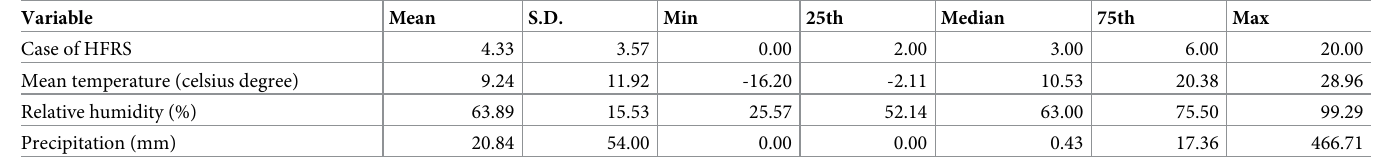
Precipitation (mm) Abbreviations: HFRS, Hemorrhagic fever with renal syndrome; S.D., the standard deviation; Min, the minimum of variables; Max, the maximum of variables. All the data are presented as weekly average or aggregate